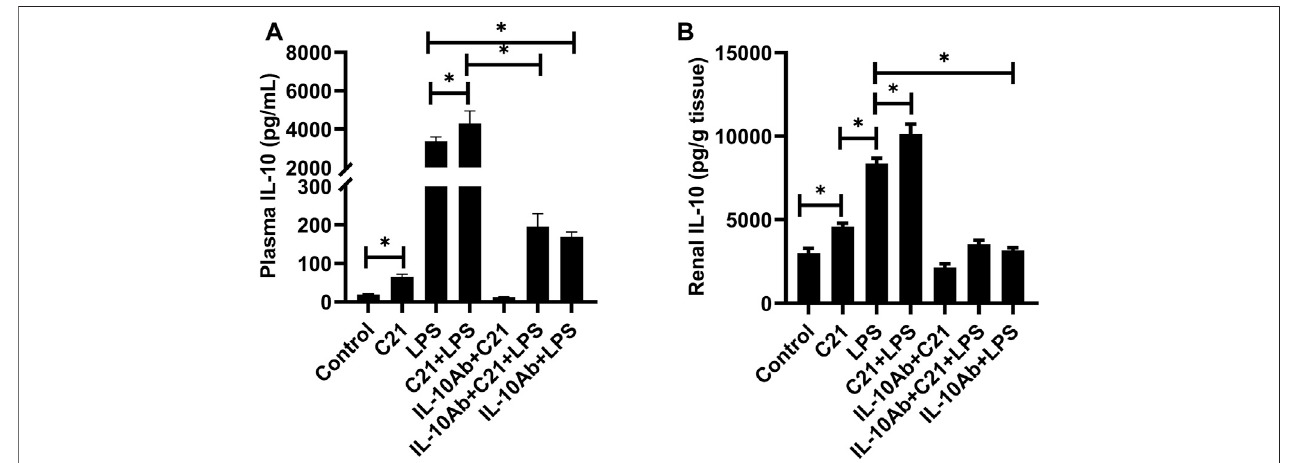
FIGURE 3 | IL-10 concentration in the (A) plasma and (B) kidney of C57BL6/NHsd mice treated with C21, LPS, or both with and without neutralizing IL-10 antibody. Data are represented as Mean ± S.E.M., analyzed by one-way ANOVA with Fisher ’ s LSD test for multiple comparisons and are considered signi fi cant at * p < 0.05.